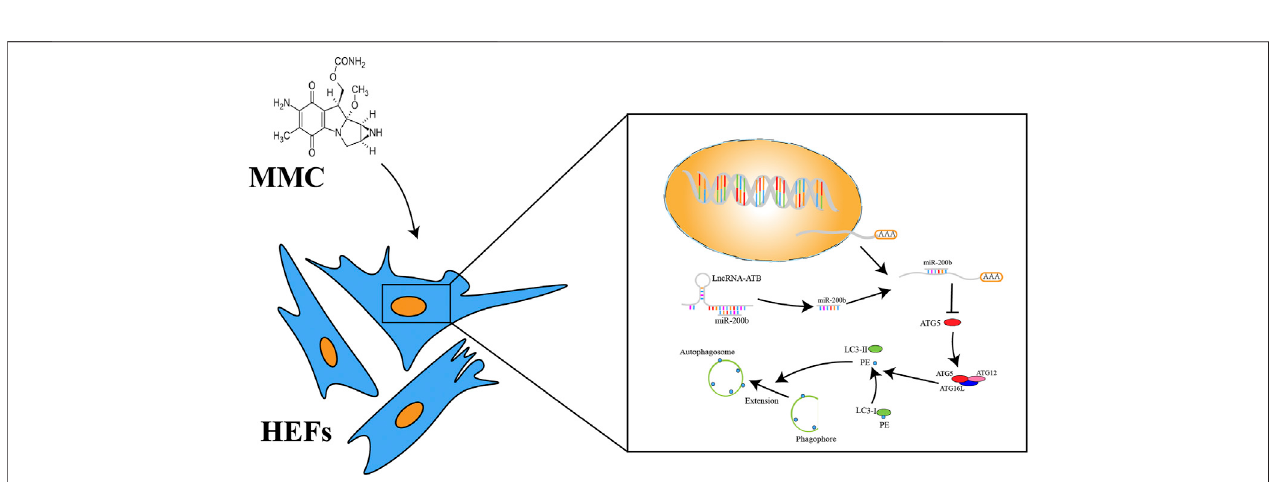
FIGURE 6 | A schema of mechanism of MMC on HEFs. MMC acted on lncRNA-ATB. LncRNA-ATB bound to miR-200b and sequestered miR-200b away from mRNA of ATG5. ATG5 protein led to the downstream change from LC3-I to LC3-II and promoted formation of autophagosome.